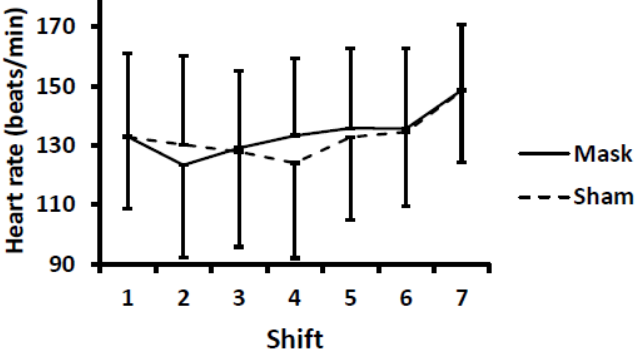
Figure 6. Heart rate during each simulated hockey shift. There were no differences between mask and sham conditions. There was a time main effect ( p < 0.01) with heart rate higher after the seventh shift (i.e., the repeated Wingate tests) compared to all other shifts. Values are means and error bars are SD. For the tissue oxygenation index, one male participant was excluded because of equipment failure during one of their conditions. For the remaining participants ( n = 25), there was a sex × mask × time interaction ( p < 0.01). For females, tissue oxygenation index was lower during the mask compared to sham condition after the seventh shift (i.e., the Wingate tests; p < 0.01; Figure 8A). Yet, for males, there was a lower tissue oxygenation index during the first six shifts for the mask compared to the sham condition ( p < 0.05), but no difference after the seventh shift (Figure 8B). Four data points (out of 350 possible data points) were not recorded because of equipment malfunction. Statistical results did not differ whether average values were imputed for missing data points or when those with missing data were excluded from the